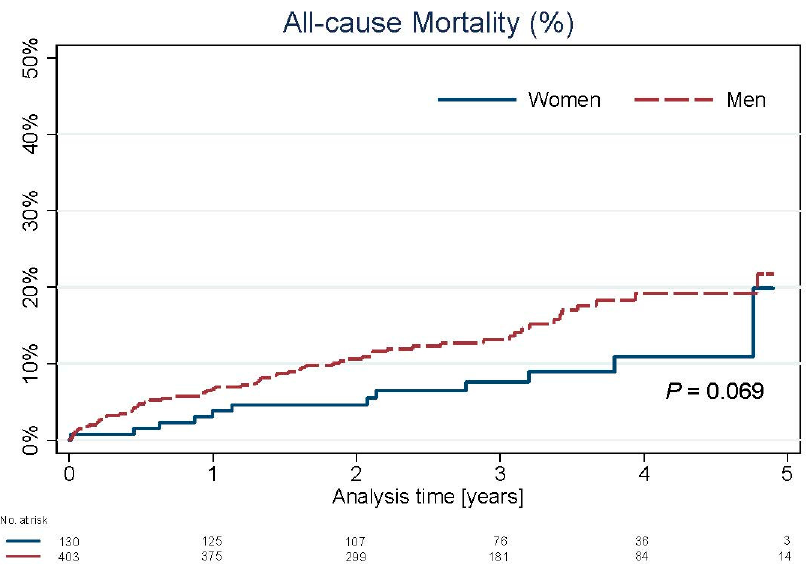
Figure 1. Kaplan–Meier analysis of all-cause mortality: women vs. men. Table 1. Baseline characteristics by